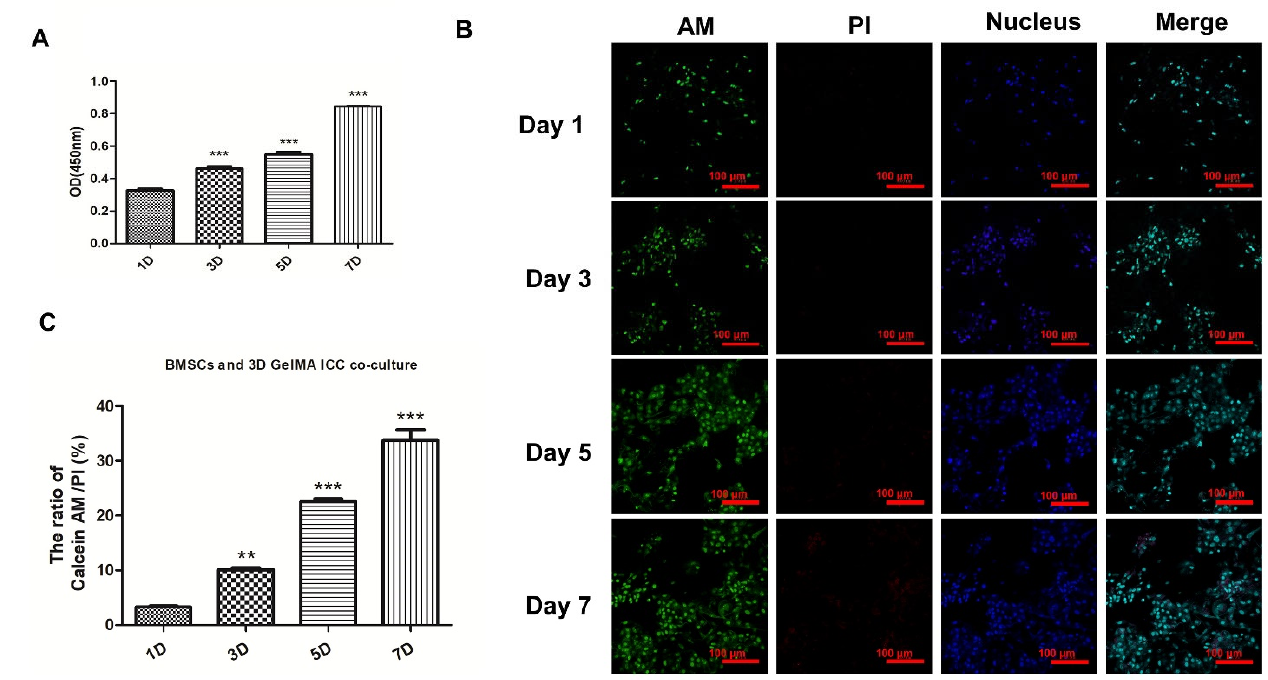
Figure 2. Effects of GelMA ICC scaffold on BMSCs viability. ( A ) The cell viability of BMSCs seeded on GelMA ICC scaffolds detected by CCK-8; ( B ) The cell viability of BMSCs seeded on GelMA ICC scaffolds detected by Calcein AM (live cells in green)/PI (dead cells in red); ( C ) The ratios of Calcein AM/PI (live cells vs. death cells); Data represent mean ± standard deviation, n = 3 (** p < 0.05; *** p < 0.01 vs. 1 day group).